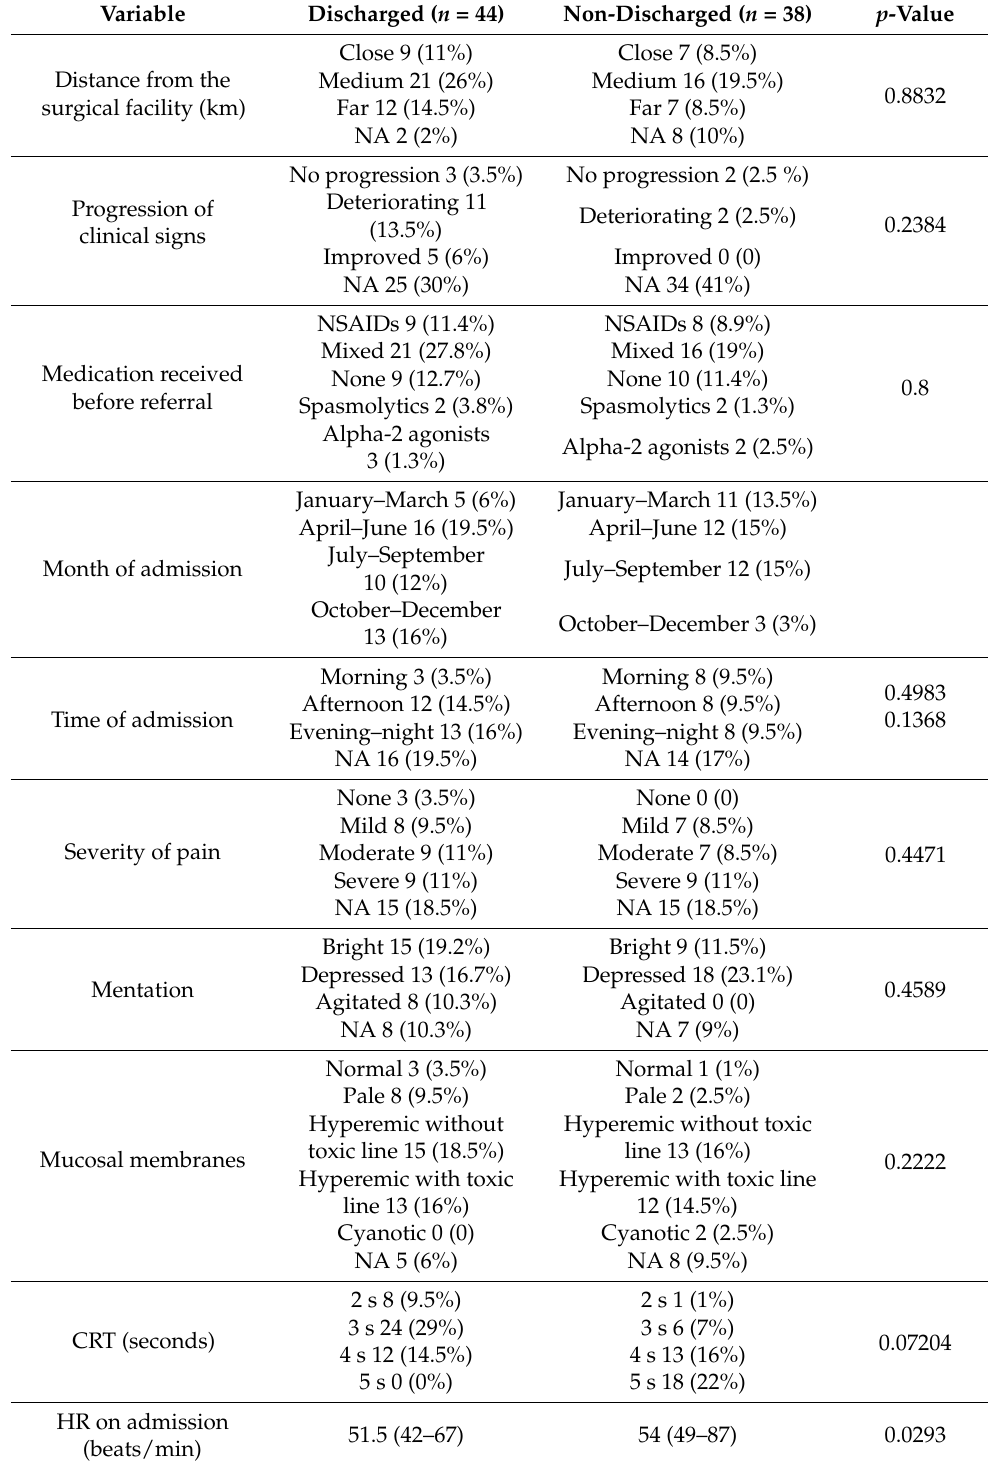
Table 8. Comparison of history data and clinical signs on admission between discharged and non- discharged horses that received a surgical treatment (PCV and TP are expressed as mean ± standard deviation; HR on admission, CRT, and HR at 3–6 h after admission/surgery are expressed as median and range) (NA not available; CRT: capillary refill time; HR: heart rate; PCV: packed cell volume; and TP: total